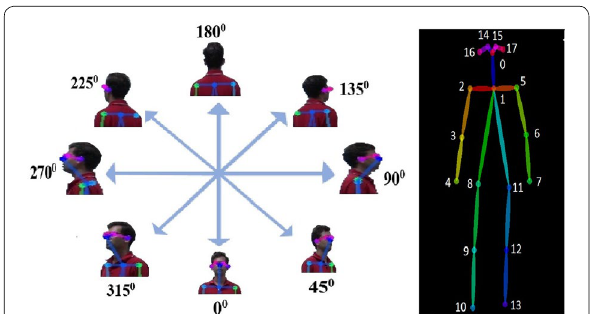
Fig. 3 Examples of different head orientation detection